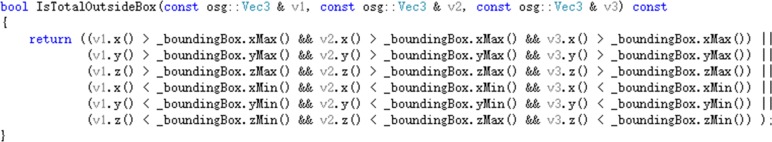
Self-adaptive adjustment process of the virtual collision detection sphere radius.